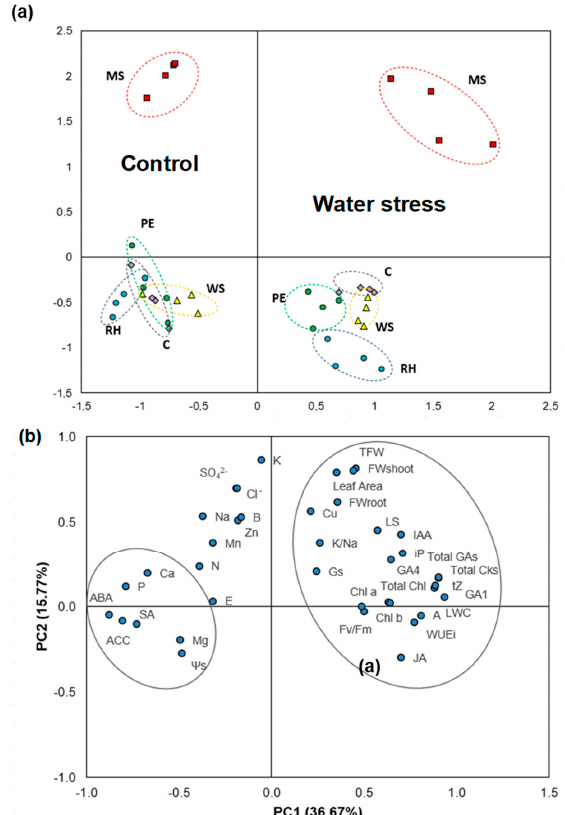
Figure 7. ( a ) Bi-Plot representing the score values and ( b ) two axes of a principal component (PC1, PC2) analysis showing the loadings of various growth-related, ionic and hormonal variables (de- noted by abbreviations) of the escarole commercial variety “Brillantes” non-mulched or subjected to different mulching treatments and cultivated under control (well-watered) and water stress (70% ETc) conditions. Circles enclose those variables/scores which cluster together in loading PCA and score PCA. Abbreviations used: boron (B), calcium (Ca), copper (Cu), iron (Fe), potassium (K), magnesium (Mg), manganese (Mn), sodium (Na), phosphorus (P), chloride (Cl − ), sulfate (SO 42 − ), root fresh weigh (FWroot), shoot fresh weight (FWshoot), leaf area (LA), total fresh weight (TFW), chlorophyll a (Chl a), chlorophyll b (Chl b), total chlorophylls (Total Clh), net CO 2 fixation rate (A), stomatal conductance (gs), transpiration rate (E), intrinsic water use efficience (WUEi), osmotic potential ( Ψ s), leaf succulence (LS), leaf water content (LWC), abscisic acid (ABA), 1-aminocyclopropane-1- carboxylic acid (ACC), indole acetic acid (IAA), salicylic acid (SA), jasmonic acid (JA), gibberellin A1 (GA1), gibberellin A4 (GA4), total gibberellins (GAs), trans-zeatin (tZ), isopentenyladenine (iP), total cytokinins (CKs), non-covered substrate (C), polyethylene mulch (PE), mushroom substrate-based hydromulch (MS), rice hulls-based hydromulch (RH), and wheat straw-based hy-dromulch